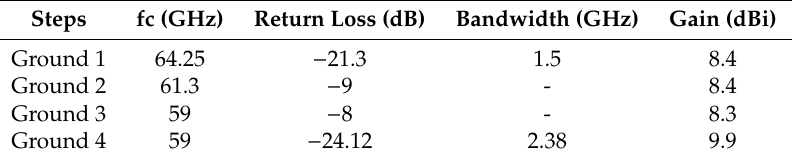
Figure 4. Simulated return loss characteristics of varied ground structures. Table 2. Simulation results of the ground plane iteration.